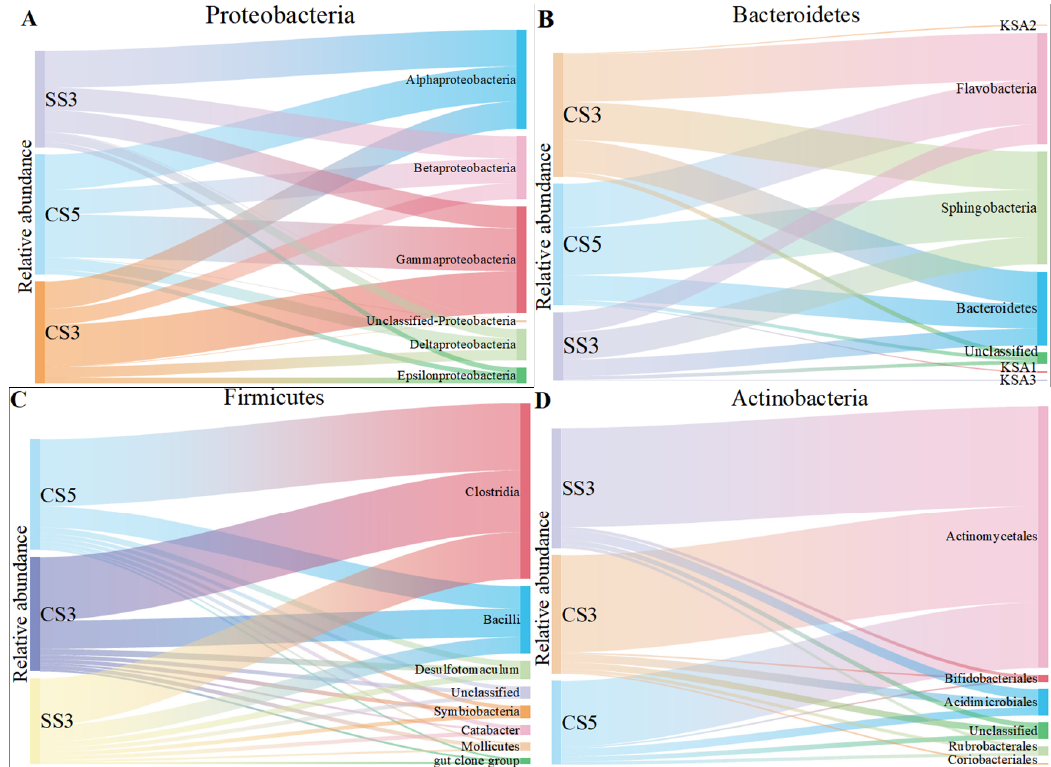
Figure 3. The taxonomic distribution of the Proteobacteria ( A ), Bacteroidetes ( B ), Firmicutes ( C ) and Actinobacteria ( D ) classes for the microarray. Actinobacteria ( D ) classes for the